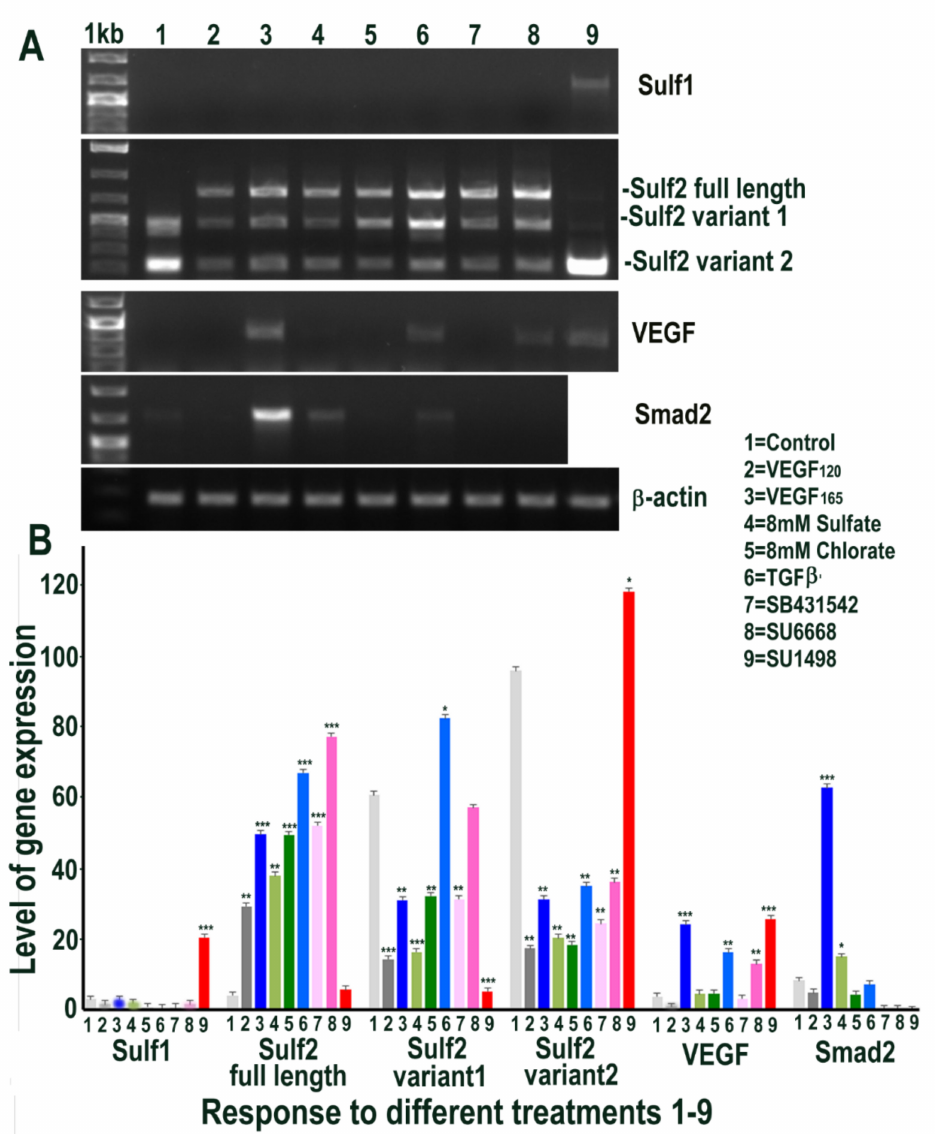
Figure 5. RT PCR analysis of HMec1 cells ( A ) and its quantification of Sulf1, Sulf2, VEGF and Smad2 ( B ) in untreated control (1) and following treatments with VEGF 120 50 ng/mL (2) VEGF 165 50 ng/mL (3) 8 mM sodium sulfate (4) 8 mM sodium chlorate (5) TGF β 1 10 ng/mL (6) 10 µ M SB431542, TGF β inhibitor (7) 5 µ M SU6668, antiangiogenic RTK inhibitor (8) and 10 µ M SU1498, VEGFR2 inhibitor (9) for 48 h. Error bars = means ± SD; *** p < 0.0001; ** p < 0.001; * p <